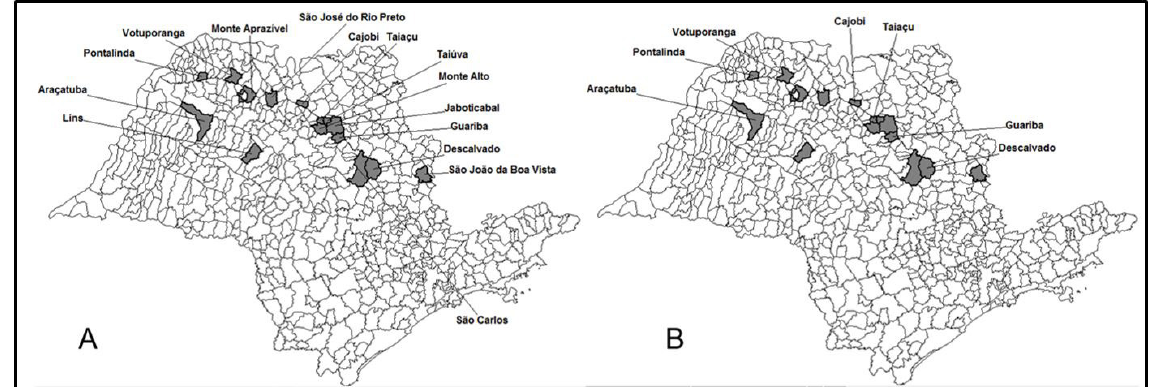
Figure 2. Geographic location of the municipalities of the State of São Paulo, Brazil, where the dairy herds were located (A). Municipalities of the State of São Paulo that had at least one positive animal for rotavirus in the PAGE, in herds of milk, from 2006 to 2010 (B).